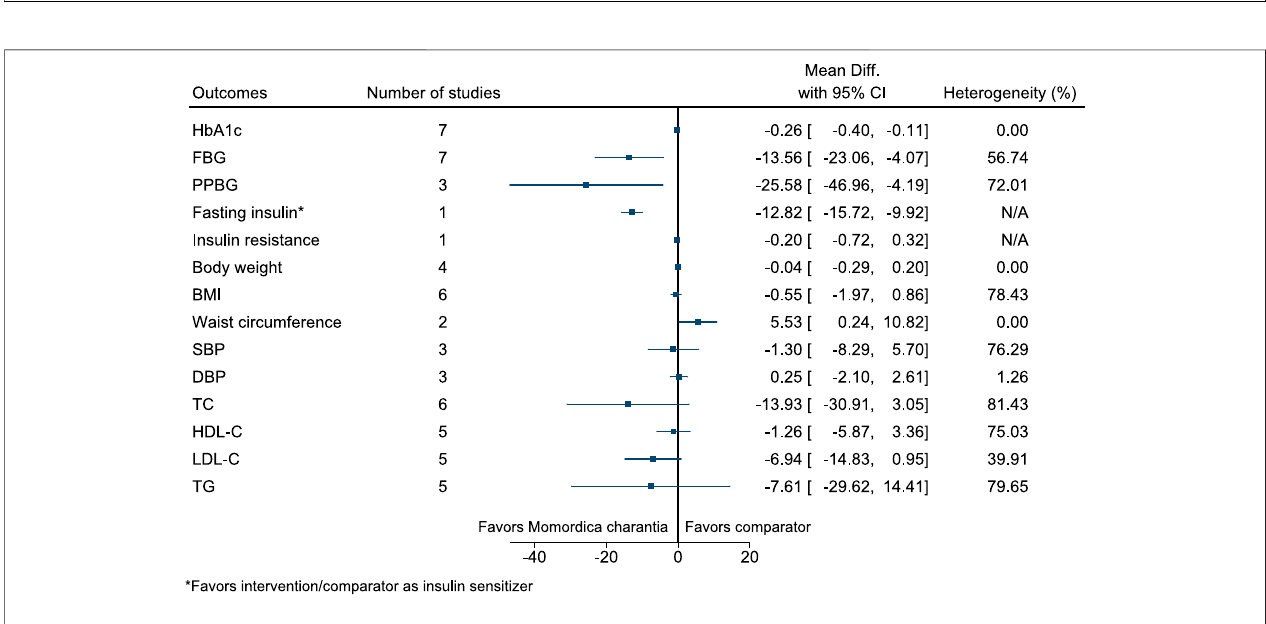
FIGURE 22 | Momordica charantia — Summary forest